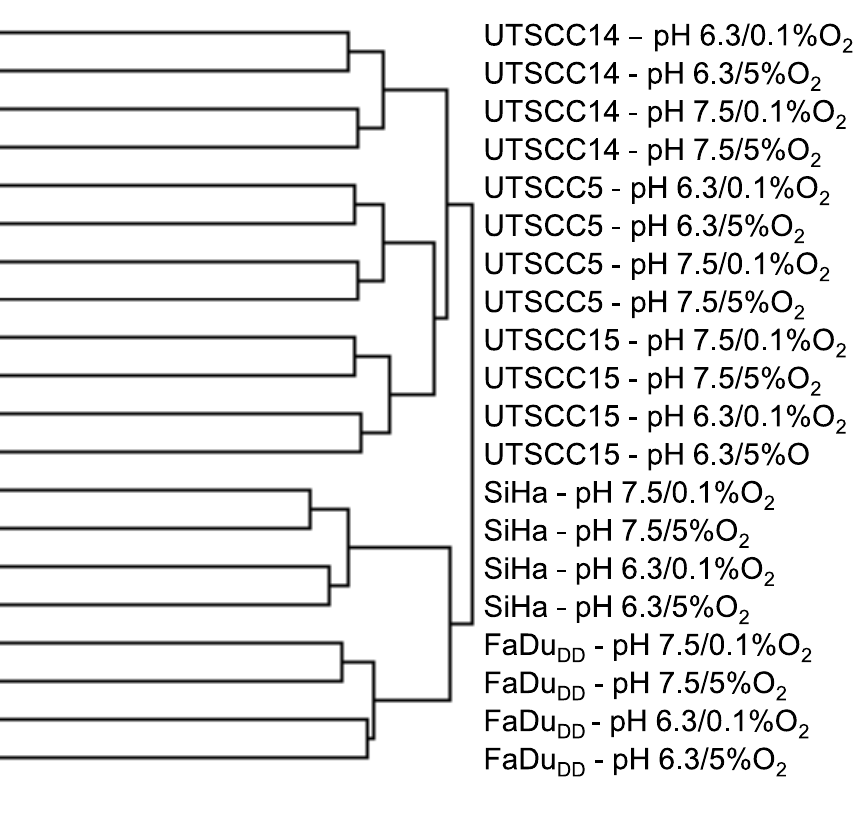
Fig 1. Effect of tumor microenvironmental factors on gene expression. Unsupervised hierarchical clustering (median centred genes, complete linkage) of gene expression data from SiHa, FaDu DD , UTSCC5, UTSCC14 and UTSCC15 cells treated with combinations of oxygen concentrations (0.1%O 2 and 5%O 2 ) and pH e (6.3 and